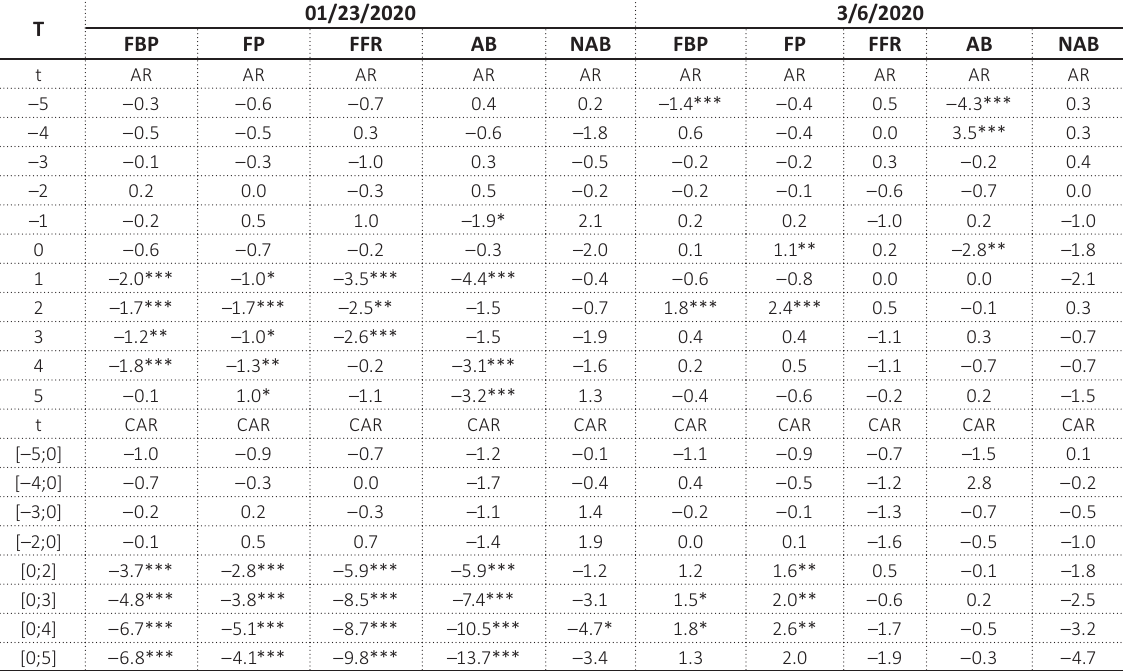
Table 2. Abnormal return (AR) and cumulative abnormal return (CAR) of the food and